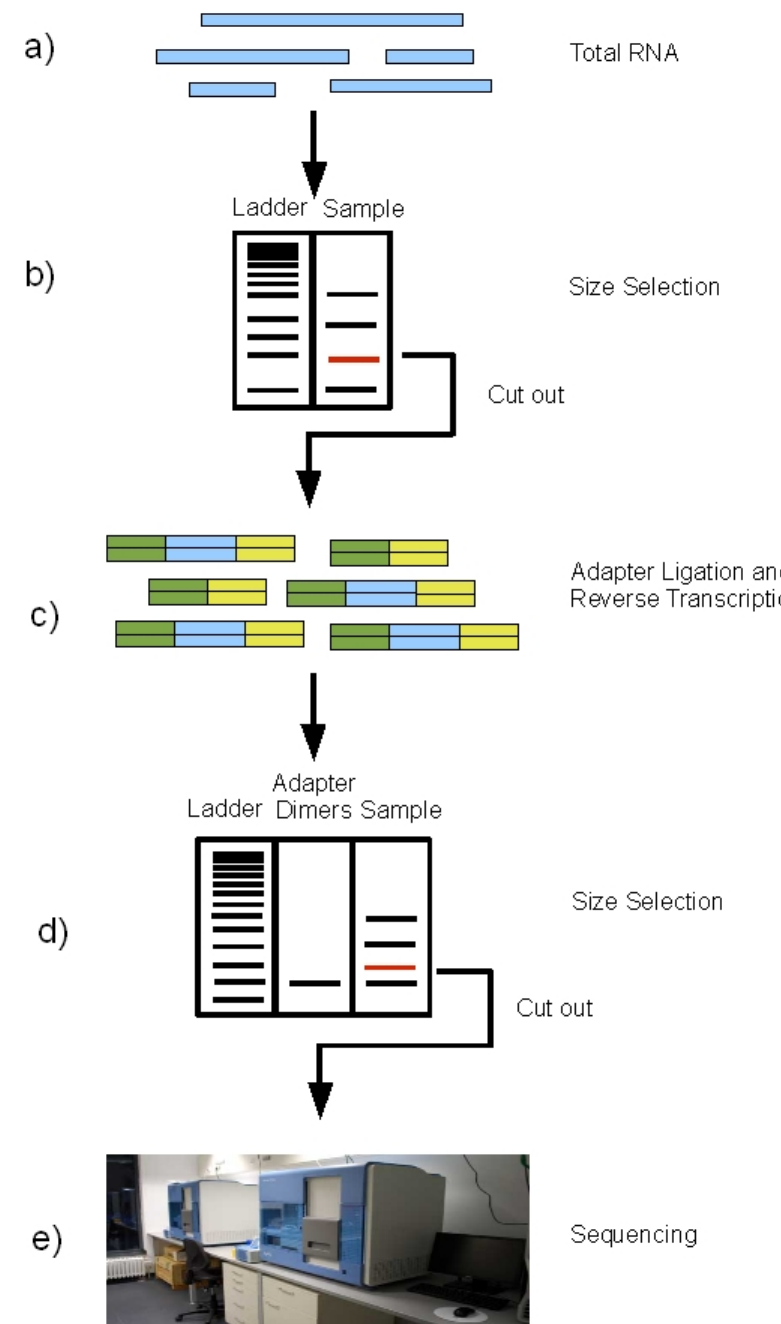
Figure 2. Schematic of the miRNA sequencing procedure on the Illumina Genome Analyzer. a) Extraction of total RNA, b) Size selection, c) Adapter ligation and reverse transcription, d) Size selection, e)